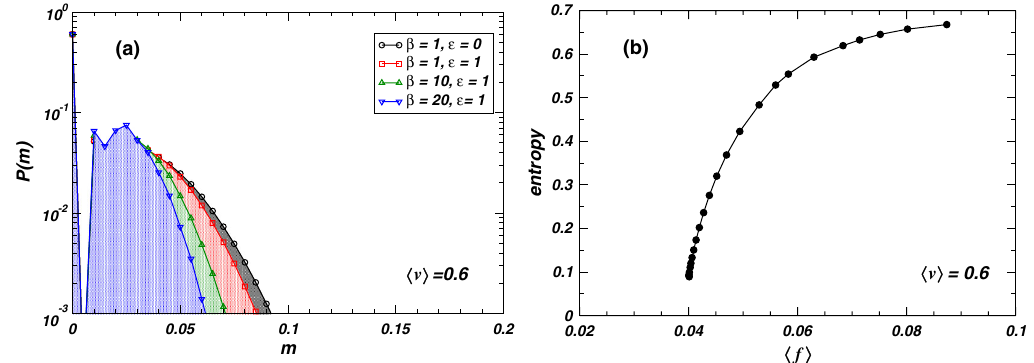
FIG. 9. (a) Distribution P ð m Þ of the probability m that a node got infected during the SIR process on random regular graphs of degree K ¼ 4 , q ¼ 0 . 1 , p ¼ 0 . 5 , h v i ¼ 0 . 6 , and different values of β and ϵ . (b) Entropy of immunization sets of density h v i ¼ 0 . 6 as a function of h f i (obtained by increasing β for ϵ ¼ 1